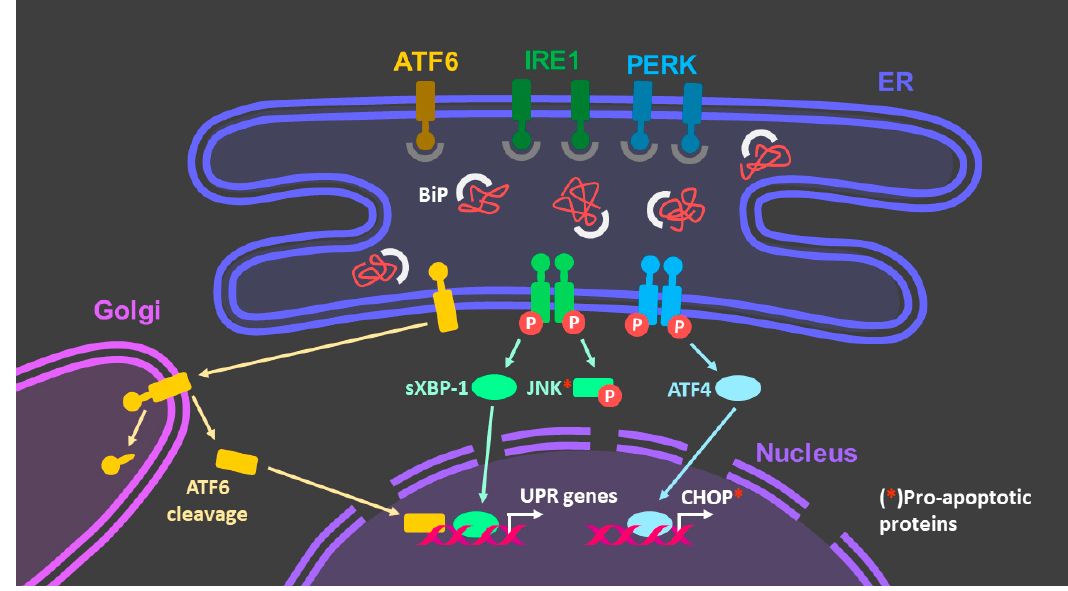
Figure 5. Activation of the unfolded protein response (UPR). The accumulation of misfolded proteins in the ER leads to the dissociation of BiP from the three ER-stress sensor PERK, IRE-1 and ATF6 and activates the coordinated unfolded protein response. ATF6 is translocated to the Golgi where it undergoes sequential cleavage and migrates to the nucleus. IRE-1 and PERK are activated by oligomerization and trans-phosphorylation. The IRE-1 endoribonuclease activity splices out an intron on XBP1 mRNA to generate XBP1s. IRE-1 also triggers the JNK pathway. PERK phosphorylates eIF2 α (not shown) and enhance the translation of ATF4 which upregulates CHOP. The integrated signaling of this three sensor regulates mRNAs decay, attenuates translation, increases chaperon sintesis, upregulates the antioxidante response, and promotes ERAD and reticulophagy. Sustained hyperactivation leads to apoptosis.